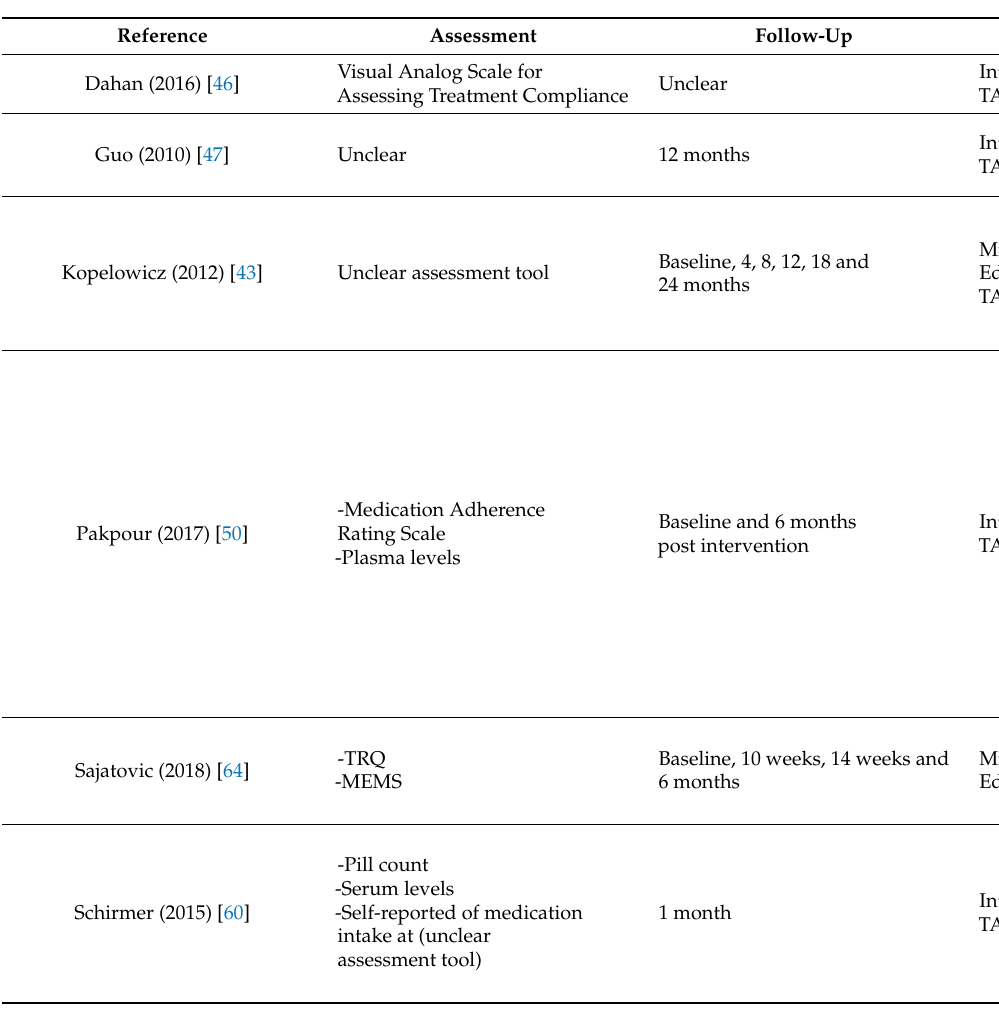
Table 5. Summary of results on the effectiveness of mixed